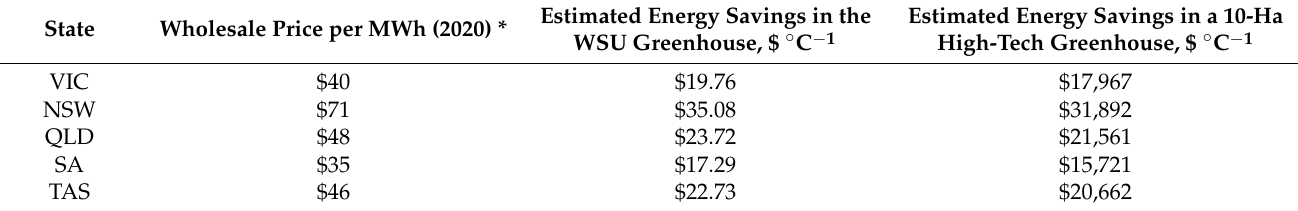
Table 6. Estimated energy cost savings for the difference between Periods 2 (7.23 kWh) and 3 (5.40 kWh) over a 9-month growth period for greenhouses in five states of